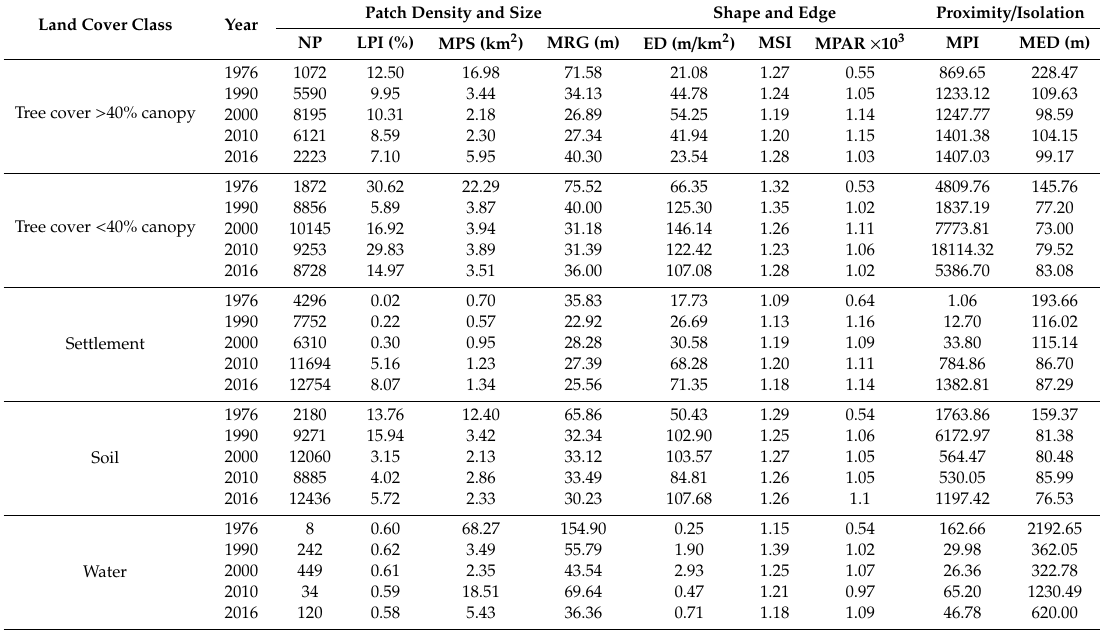
Table A2. Land cover class level landscape matrix parameters results for 1976, 1990, 2000, 2010, and 2016.